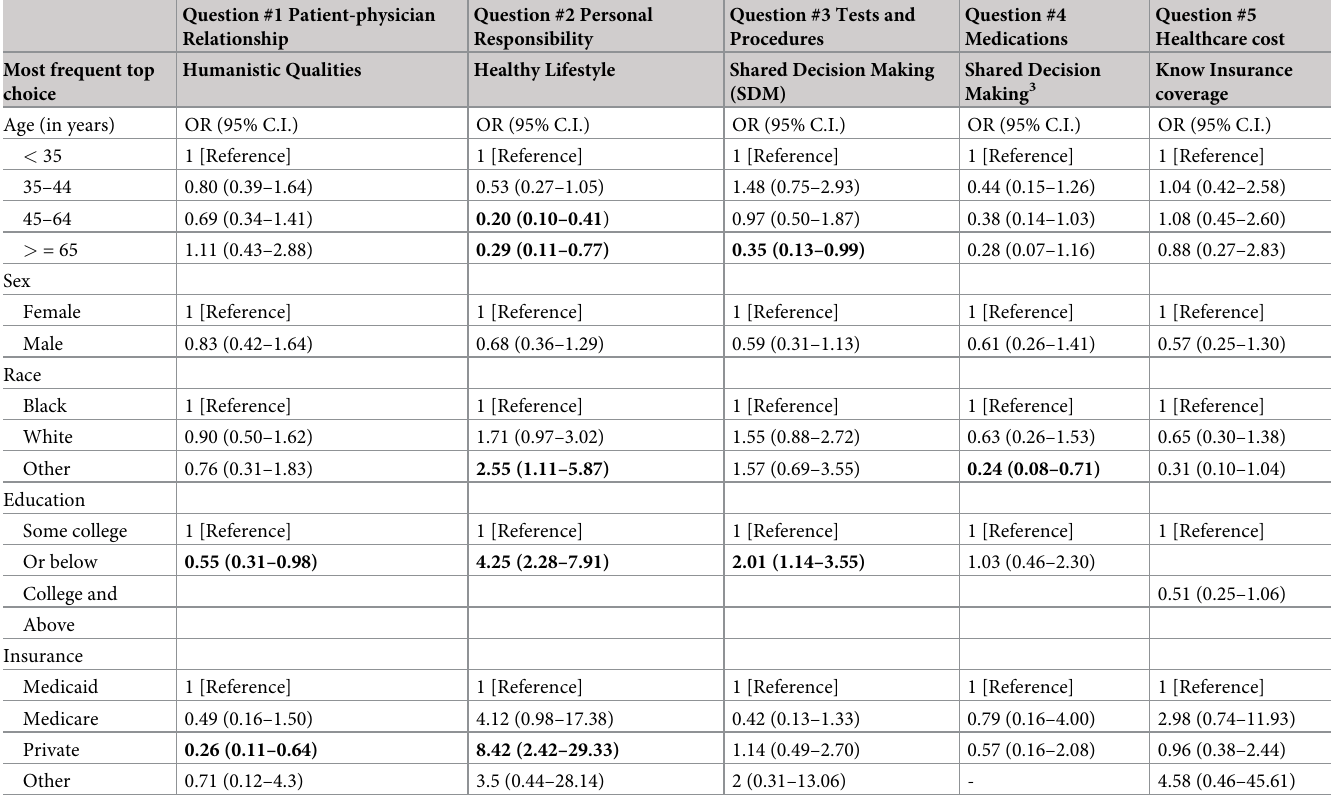
Table 4. Univariate analysis for predictors of most frequent top choice for each